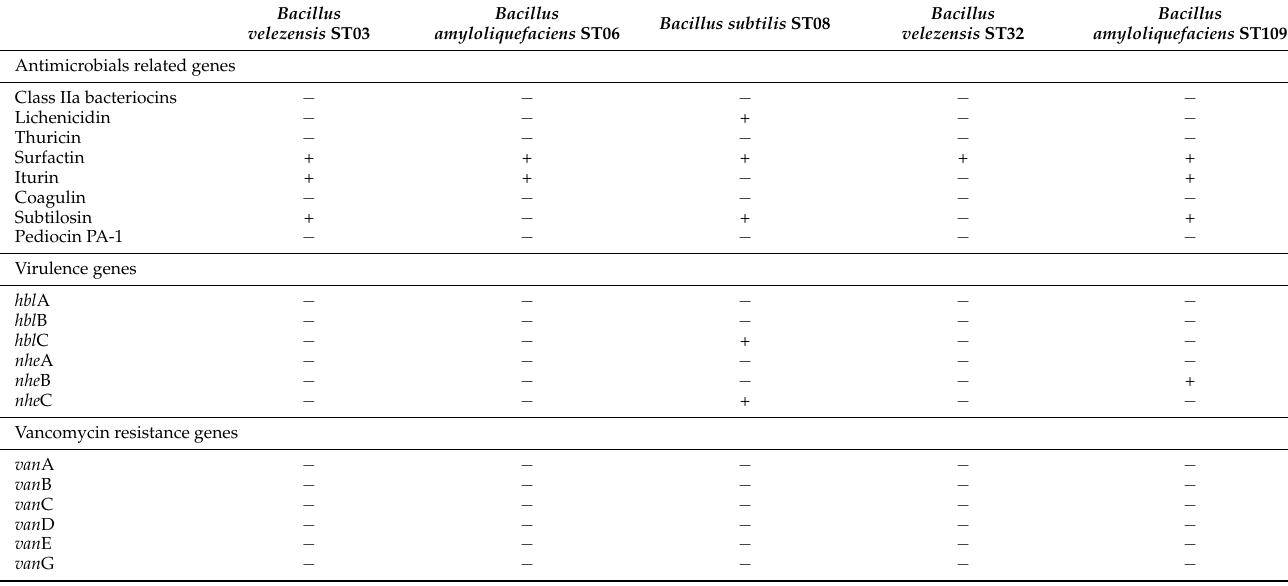
Table 4. Spread of antimicrobials, virulence- and vancomycin-resistant related genes in DNA obtained from B. velezensis ST03, B. amyloliquefaciens ST06, B. subtilis ST08, B. velezensis ST32, and B. amyloliquefaciens ST109. Bacillus Bacillus velezensis ST03 amyloliquefaciens ST06 Antimicrobials related genes Class IIa